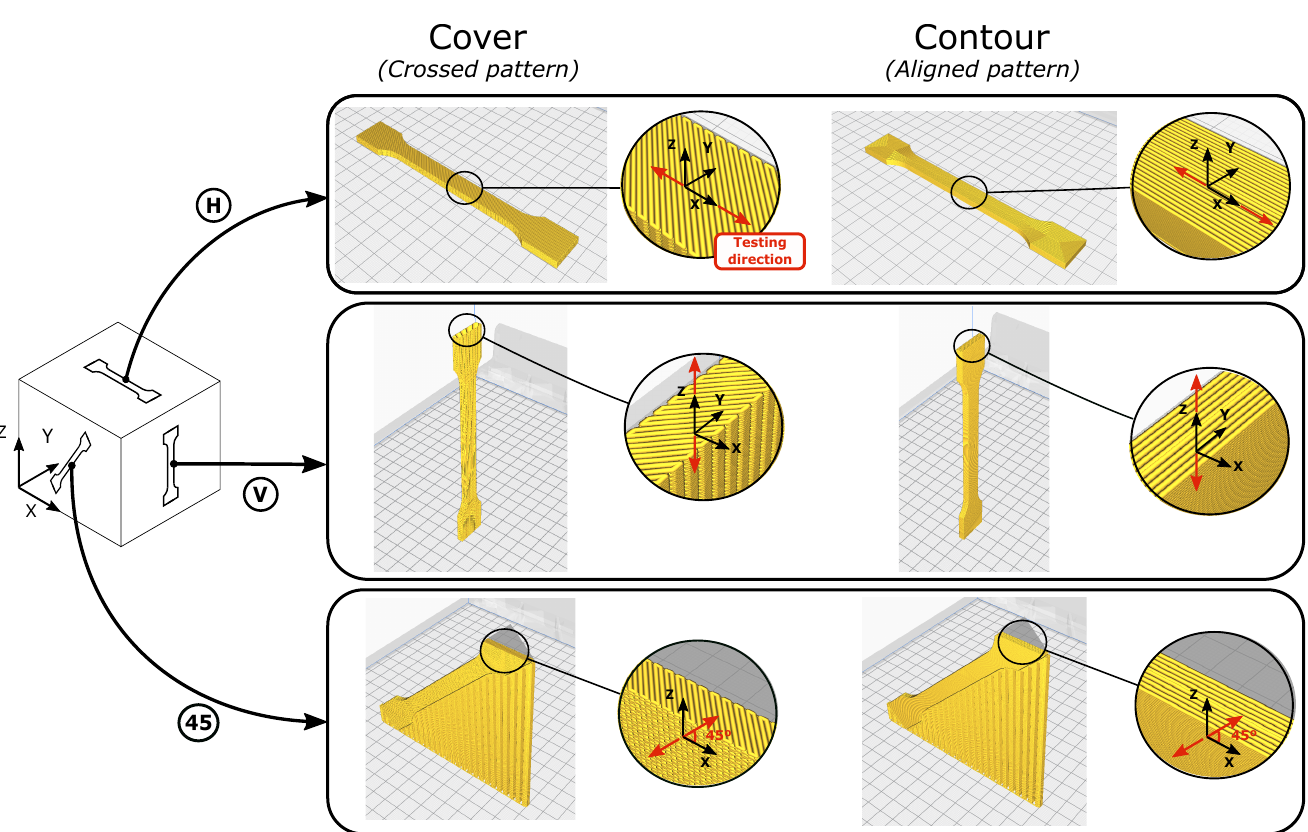
Figure 2. Orientation of the dog bone specimens.